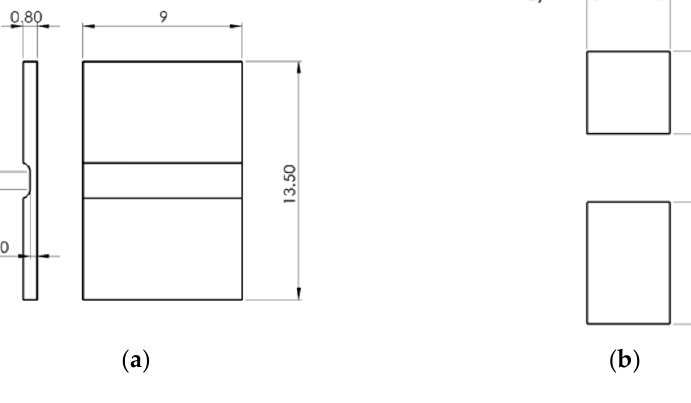
Figure 12. Geometries in millimeter of the samples designed in SolidWorks software extracted from DED-processed honeycomb structures employed in ( a ) plane strain test (PS), ( b ) compression test (CT) and ( c ) biaxial test (BT). Table 3. Results of tensile, plane strain, biaxial and compression testing including the dimensions of the samples before and after testing, yield strength and ultimate tensile strength (if